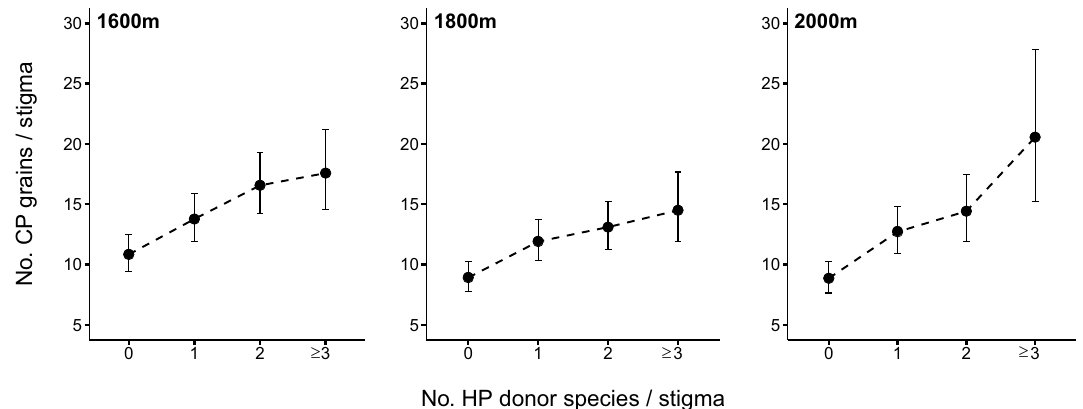
Figure 1. Adjusted mean values (± 1 SE) of conspecific pollen (CP) receipt from the fitted global model for each altitude (1600, 1800 and 2000 m) and level of heterospecific pollen (HP) richness (i.e., number of HP donor species/stigma). For estimating these adjusted means, model was re-run considering HP richness as a factor rather than as a continuous variable, thus “0” category represents the absence of HP, “1” the presence of HP from one donor species, “2” HP from two species, and “= or > 3” HP from three or more donor species.